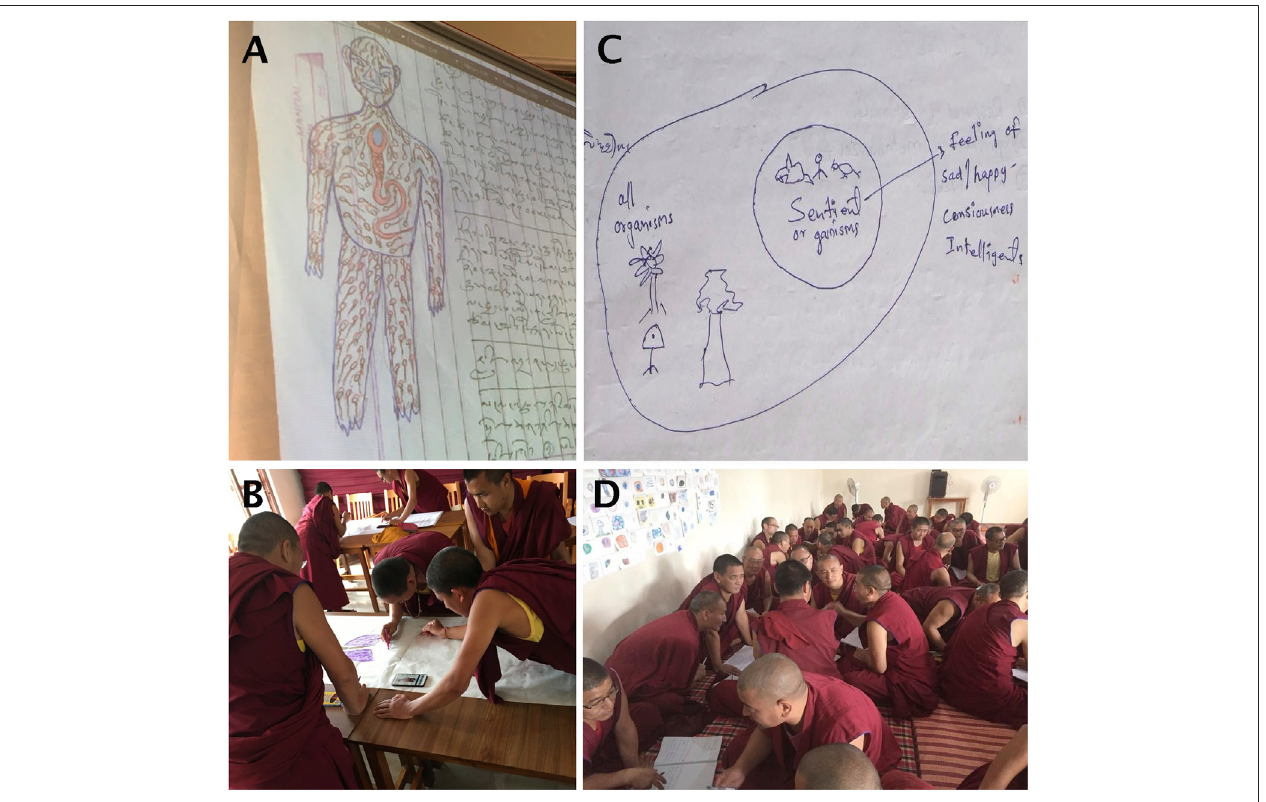
FIGURE3 | DTL and culturally relevant ways ofknowing in thebiologyclassroom. (A) Journal drawing ofsperm all over the male body. (B) Monks drawing life-size diagrams of the human body on butcher paper, using red/blue/yellow crayons to label the products of mesoderm/ectoderm/endoderm (the three embryonic germ- layers). (C) Journal drawing of a Venn diagram showing the monastic ’ s distinction between living things and living beings. (D) Monastics using journal drawings as evidence during small group